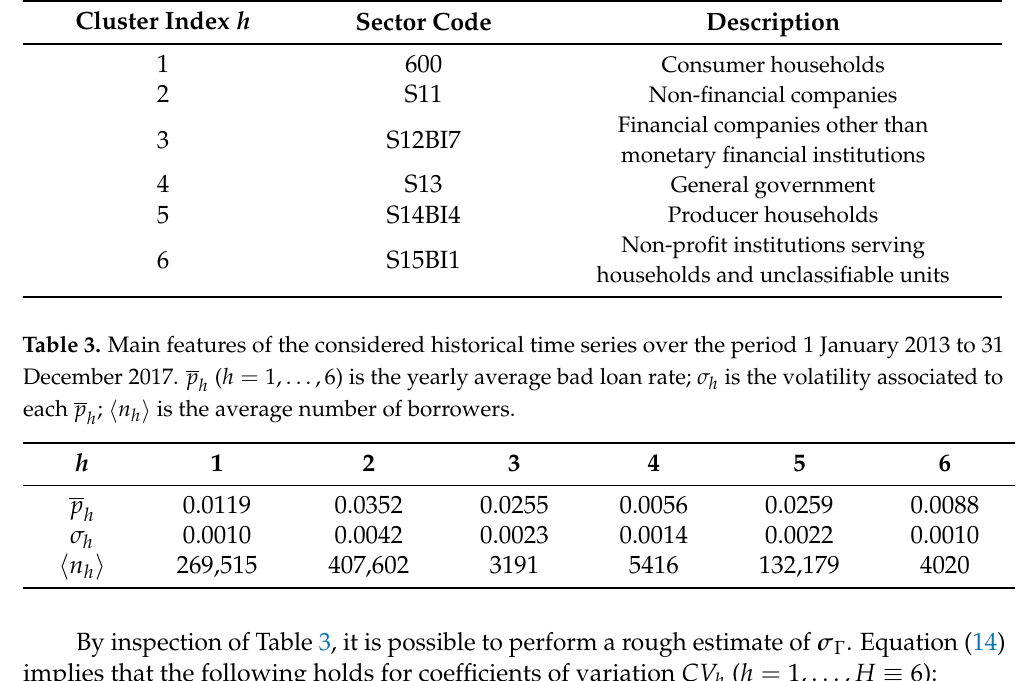
Table 2. Definition of the clusters h = 1, . . . ,6 used in data set TRI30496 . Cluster Index h Sector Code